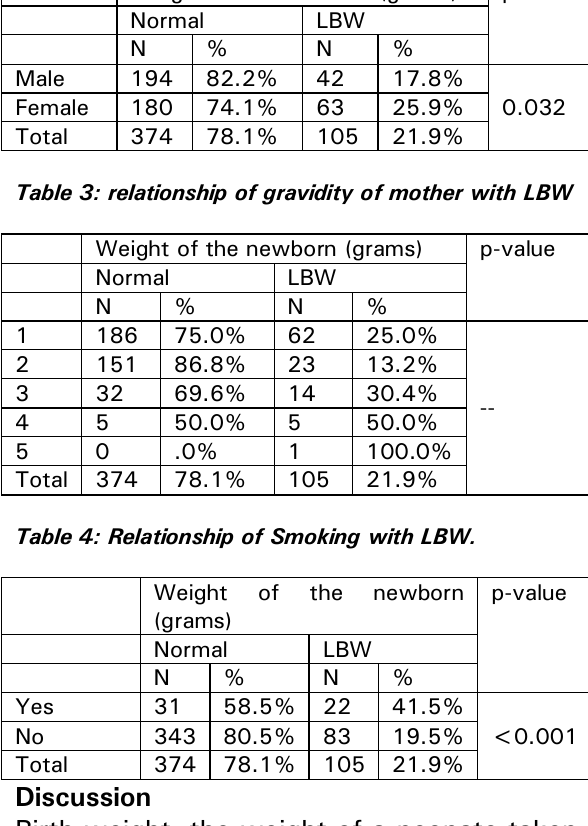
Table 2: relationship of sex of newborn with LBW Weight of the newborn (grams) p-value